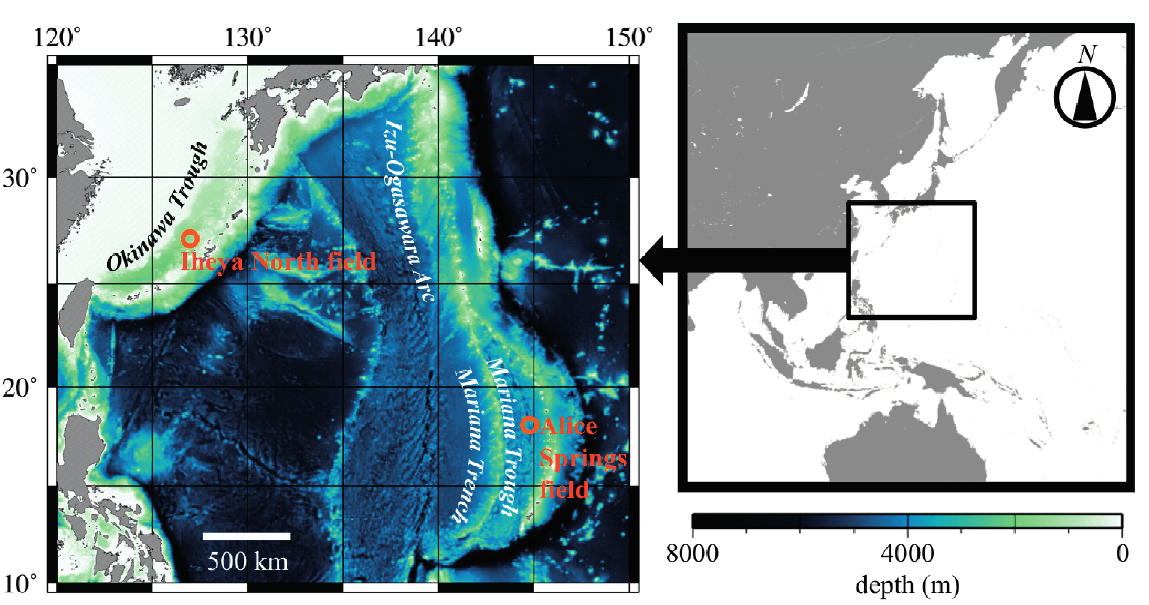
Figure 1. Sampling sites for Neoverruca . Iheya North field (for Neoverruca sp.) is located in the Okinawa Trough and the Alice Springs field ( N. brachylepadoformis ) is in the Mariana